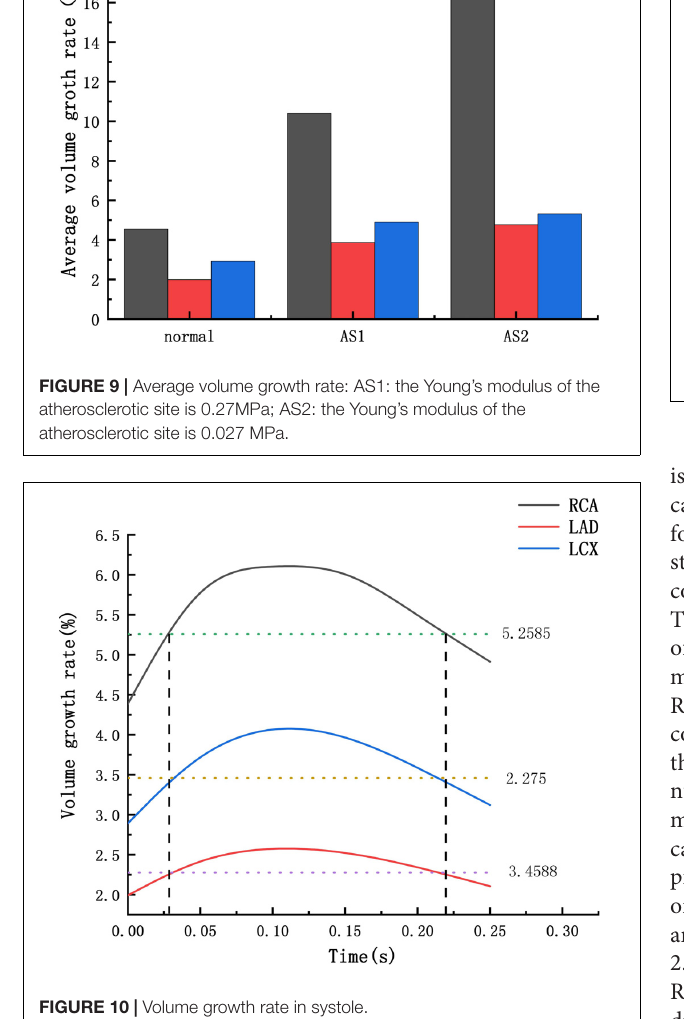
FIGURE 10 | Volume growth rate in systole.